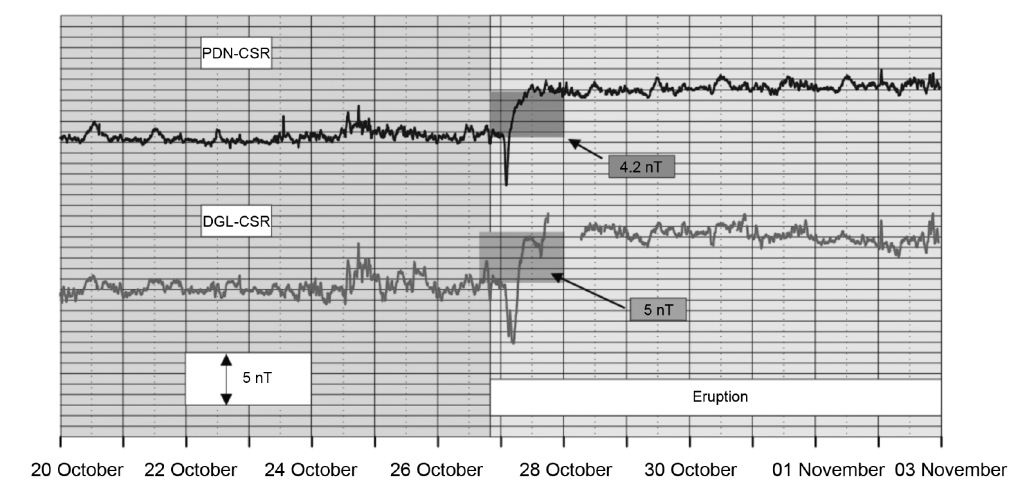
Fig. 3. Plot of 10-min means of differential magnetic field at PDN and DGL stations with respect to the CSR reference station between 20 October and 03 November